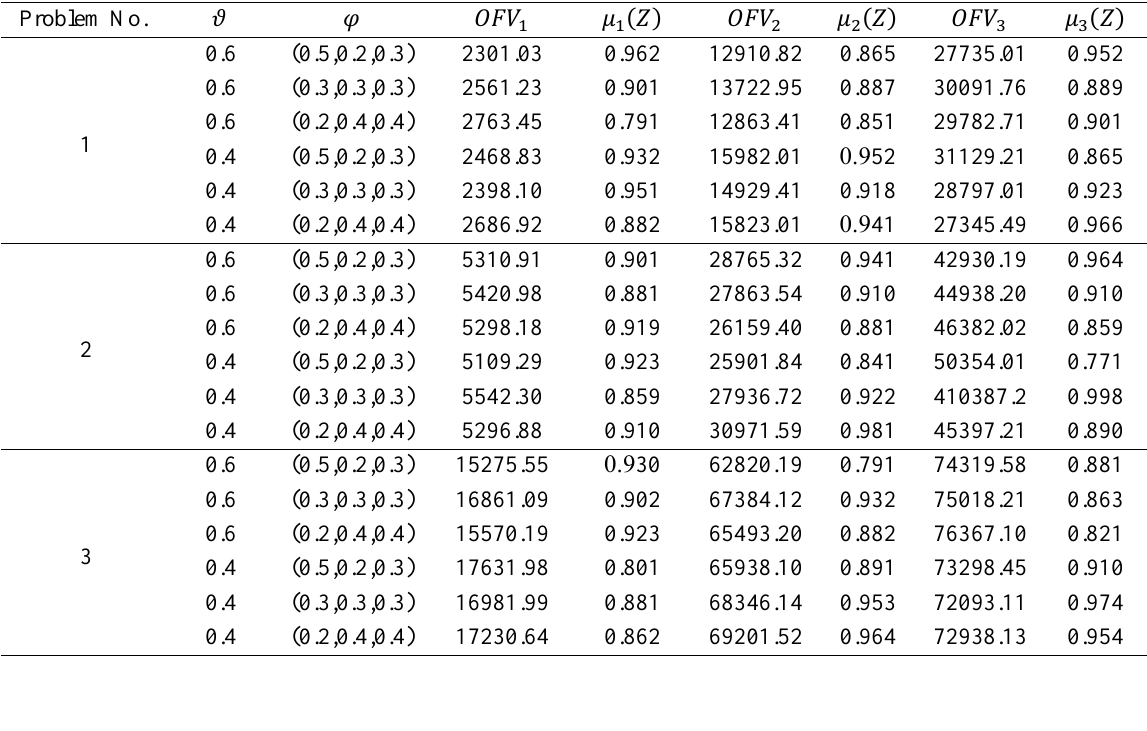
Table 5. Summary results of test problems.